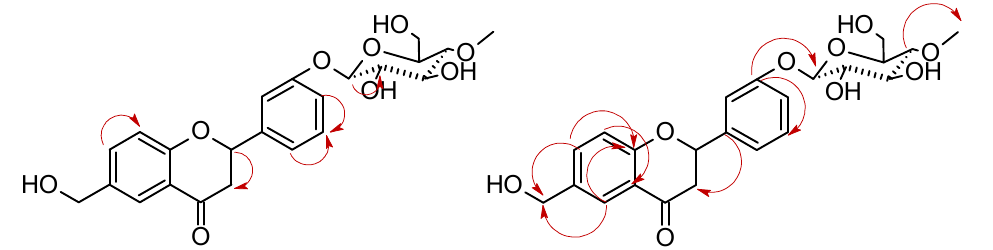
Scheme 7. Key COSY (on the left) and HMBC (on the right) correlations for the structure elucidation of product 4c . product 4c